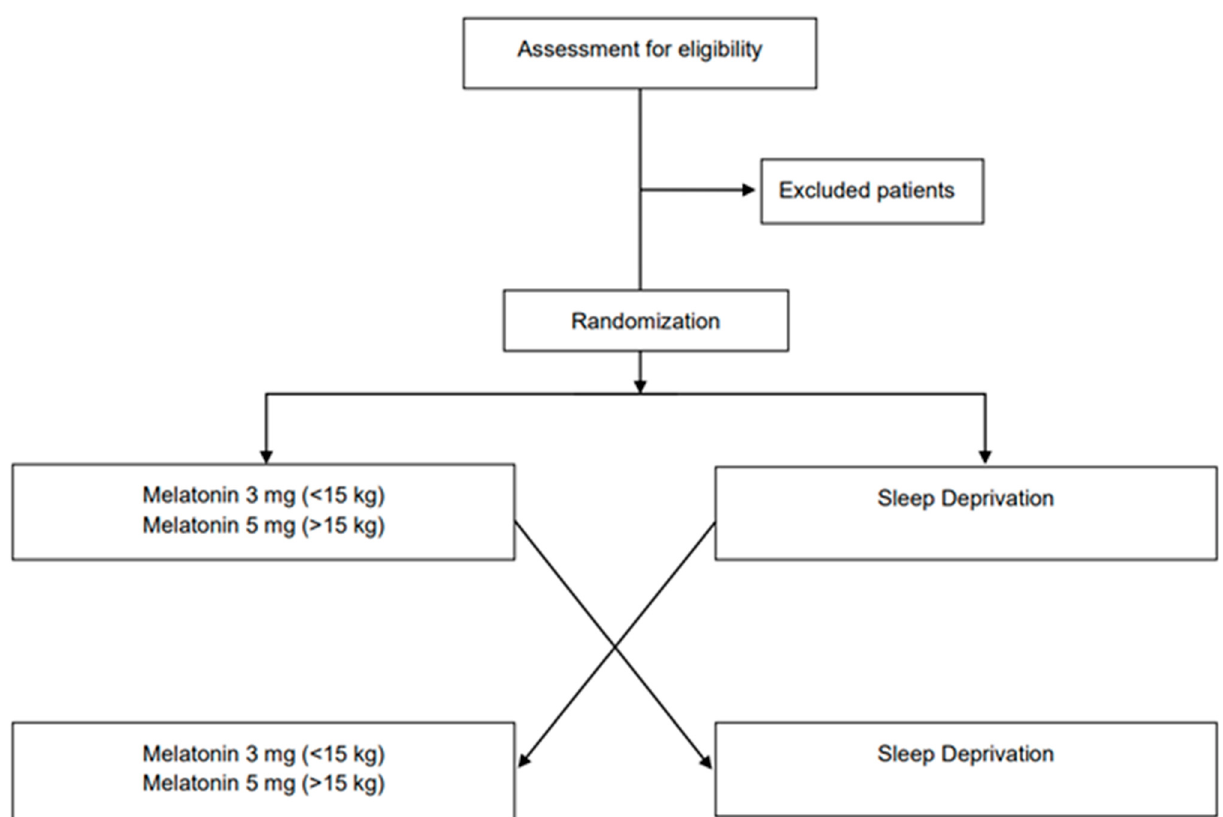
Figure 1. CONSORT flowchart for enrollment and randomization.